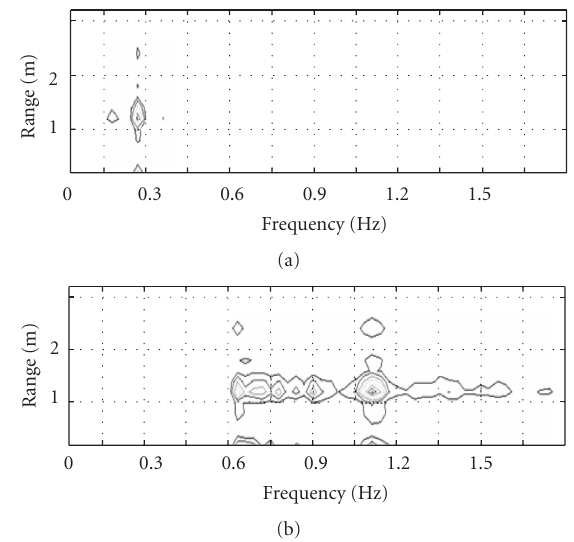
Figure 2: Range-frequency matrix for the examinee at 1.5m range: (a) (upper) before breathing harmonics rejection; (b) (lower) after breathing harmonics rejection.